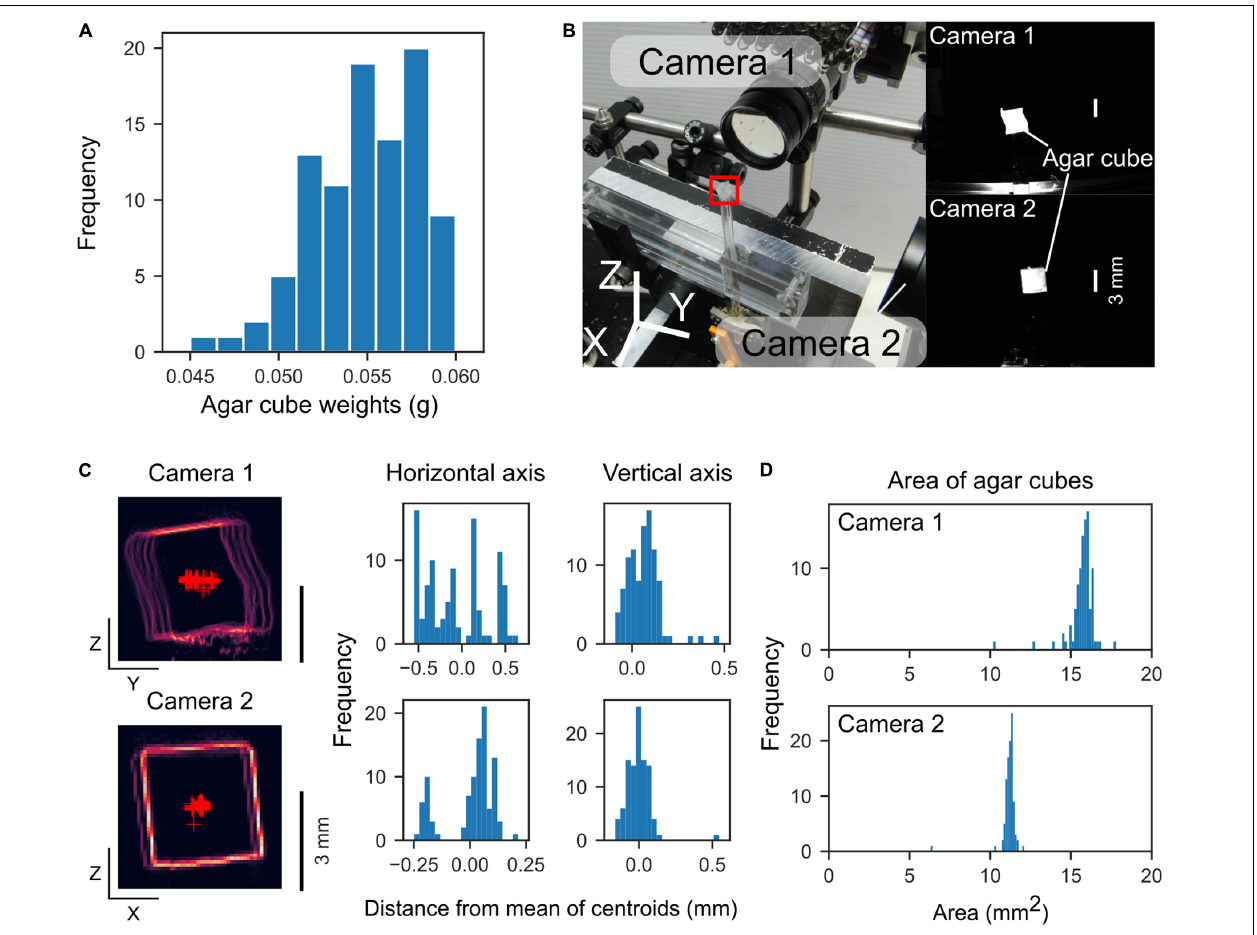
FIGURE 3 | Weight and location of the extruded agar cubes. (A) Histogram of agar cube weights (mean: 0.055 g, n = 95 cubes, 4 sets). (B) Left, Photograph of the measurement configuration. Two orthogonally positioned cameras capture front and side images of the agar cube. The red square indicates the location of an agar cube. Right, Agar cube images by the cameras. (C) Left, Outlines of agar cubes captured by the two cameras. The outlines of 99 agar cubes were overlaid. Red “plus” markers indicate centroids of the agar cubes. Right, Histograms of the distance from the mean of centroids along with horizontal and vertical axes. (D) Histograms of the area of the agar cubes captured by each